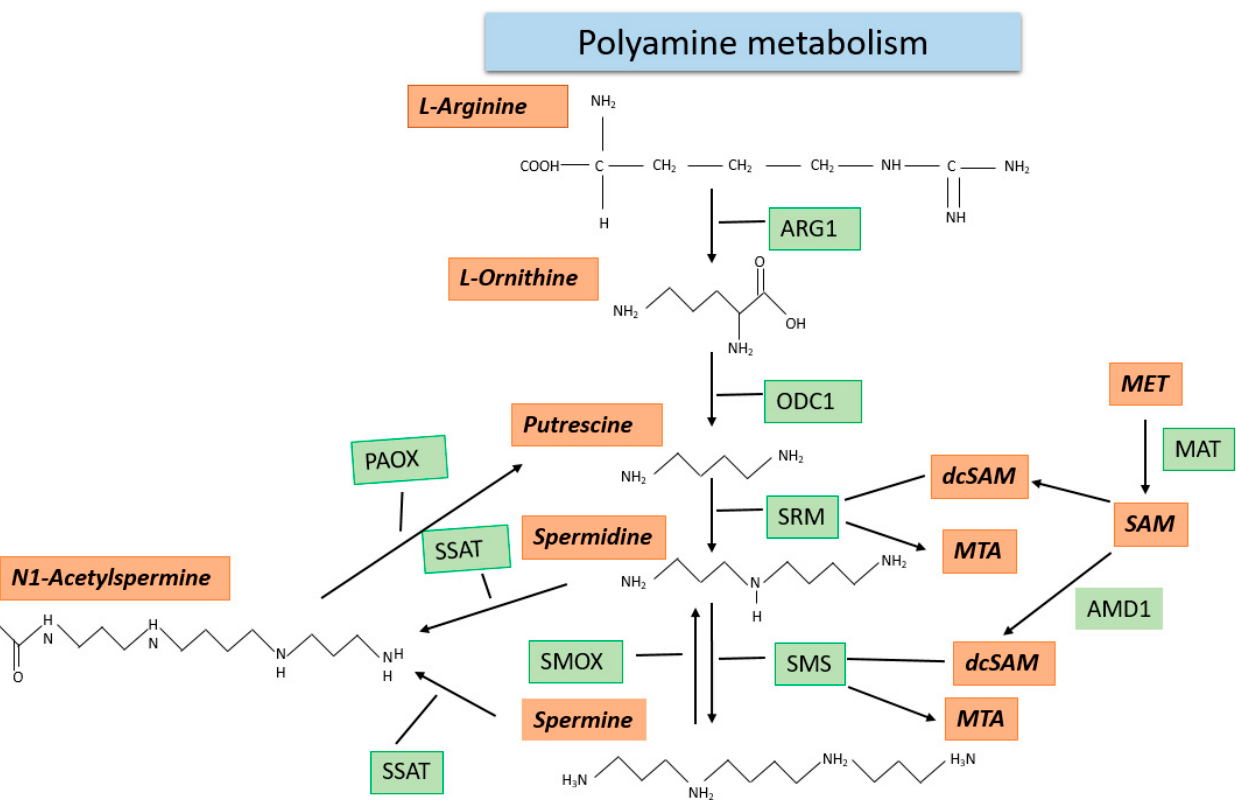
Figure 4. Polyamine metabolism.